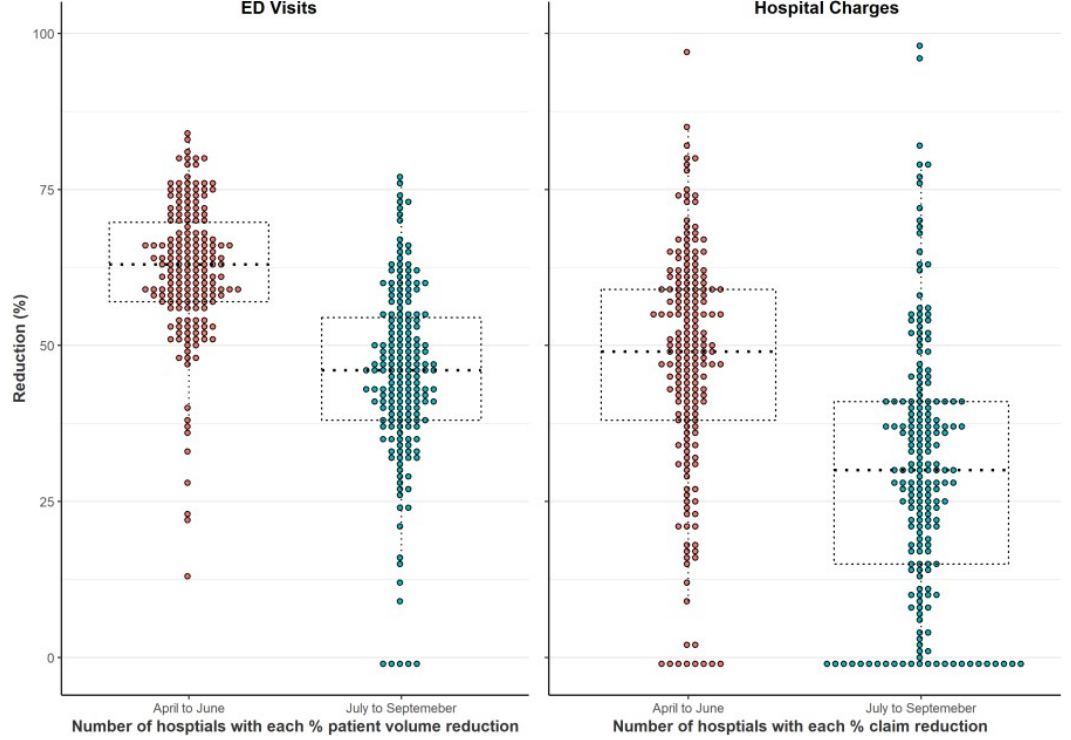
Figure 2. Distribution of pediatric ED visits and hospital claim charge reduction in Florida hospitals. (Dotted line represents Median and Interquartile range).